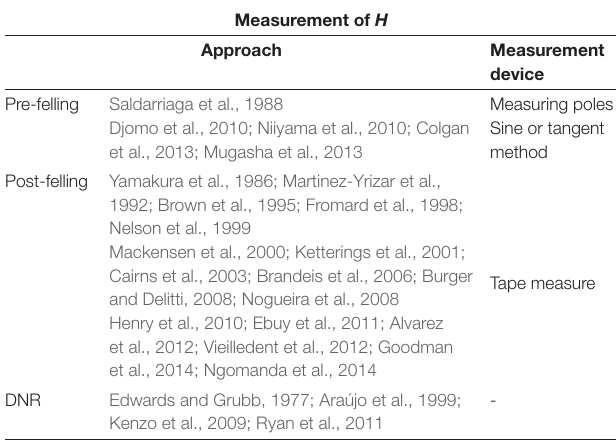
TABLE 2 | The approach and measurement device used across the 26studies for measuring the predictor variable H